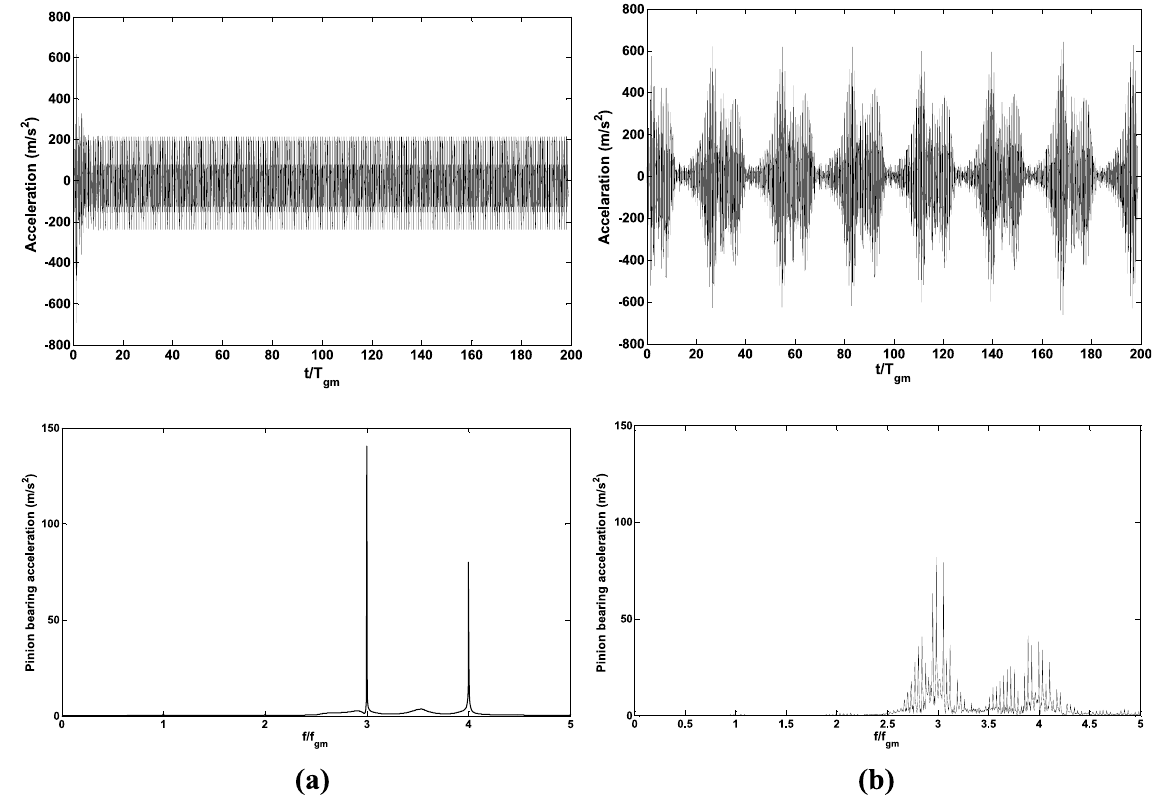
Fig. 9. Time evolution and spectra of the acceleration of the pinion bearing for constant load case (a) and time varying load case